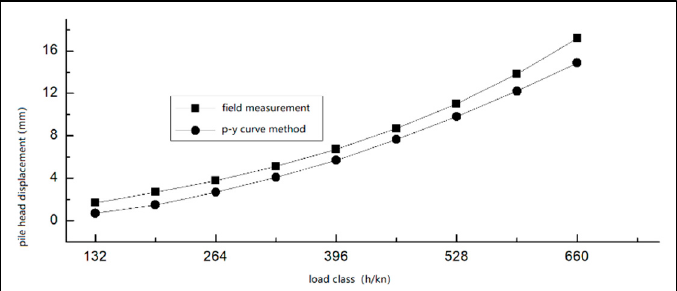
Figure 17. Comparison diagram of load–displacement curve of 2-X2# test pile.